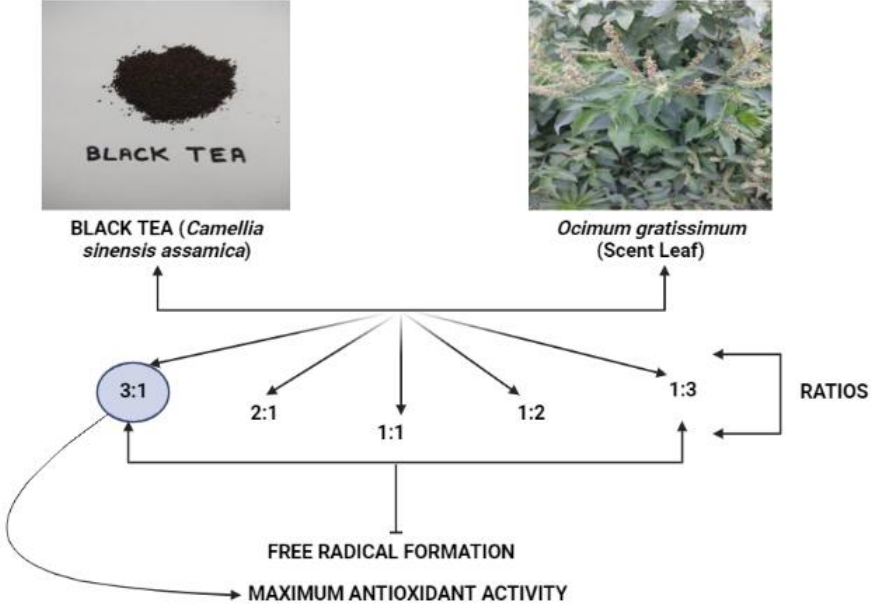
Figure 1. Effect of altering the proportion of black tea and O. gratissimum at five different ratios.